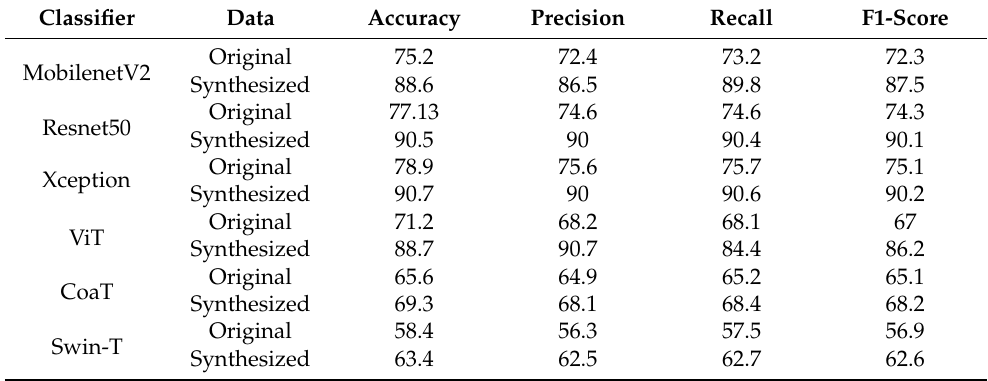
Table 2. Performance comparison for classification of corneal conditions among obstetric models